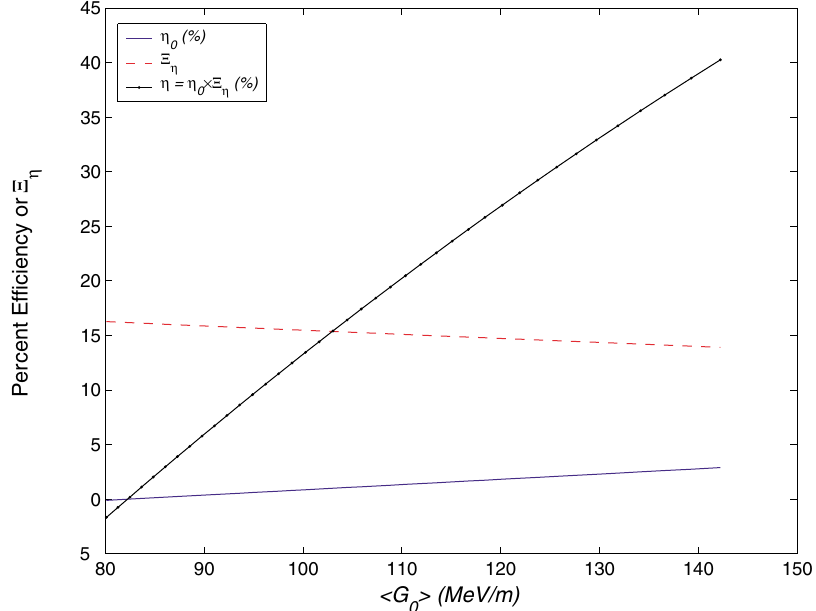
FIG. 6. (Color) Efficiency without and with energy recycling for q (cid:1) 2 : 2 fC and (cid:29) (cid:1) 0 . The efficiency has been maximized for i by trading off r and E each value of h G 0 82 MeV the retarding gradient is greater than the unloaded gradient, and, therefore, (cid:21) < 0